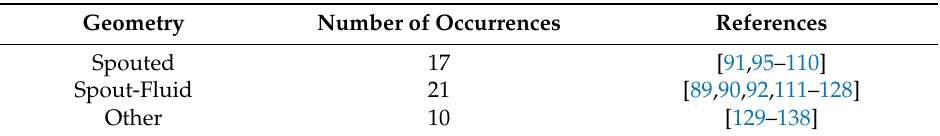
Table 1. Works on CFD-DEM modelling of SB.